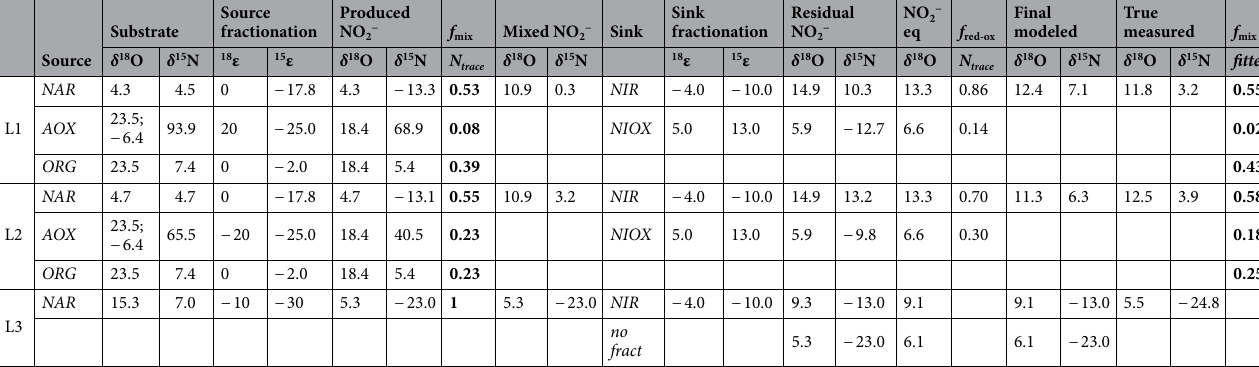
Table 2. Nitrite stable isotope model to determine sources mixing proportions. In the first step, nitrite isotopic signature ( δ 18 O, δ 15 N) is modelled based on: (i) the nitrite sources taking into account measured substrate isotopic signatures (NO 3− for NAR , NH 4+ for AOX and organic N for ORG ), fractionation factors ( 18 ε , 15 ε ), and sources mixing proportions according to the results of the N trace model ( f mix N trace ); (ii) nitrite sinks with their characteristic isotopic fractionation factors ( 18 ε , 15 ε ) including the nitrite reduction–oxidation ratio after results of the N trace model; and (iii) nitrite equilibration with water (NO 2− eq) including measured extent of O-exchange of 0.25, δ 18 O of -5‰ and 18 ε eq for 20 °C. In the second step, modelled nitrite isotopic signature were fitted to the measured values by adjusting the sources mixing proportions ( f mix fitted ) to find the ideal fit of modelled vs. measured δ 15 N values.